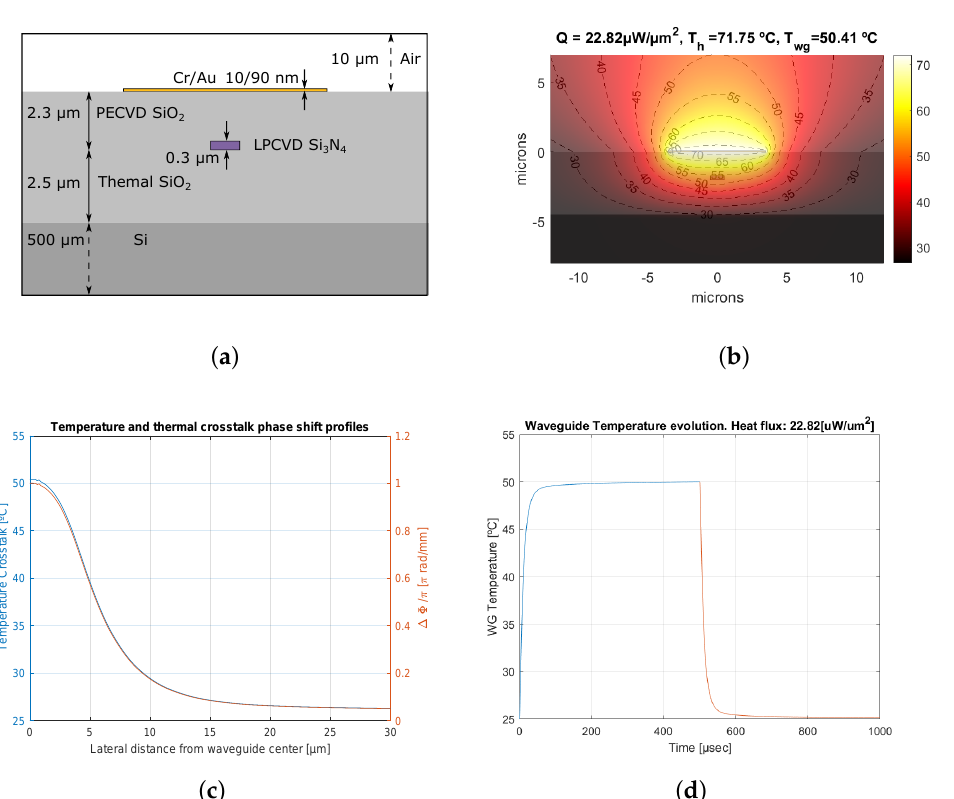
Figure 1. Fully-clad TO phase shifter cross-section for CNM-VLC SiN platform ( a ), temperature contour plot corresponding to a phase shift of π -waveguide width of 1 µ m and heater width of 7 µ m- ( b ), horizontal temperature profile from the waveguide core and associated crosstalk phase shift ( c ), and waveguide core heating and cooling transient states temperature ( d